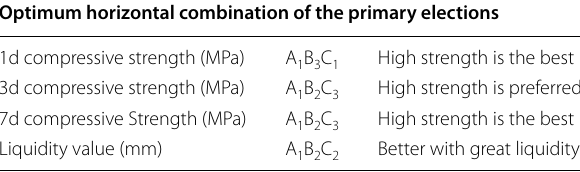
Table 21 Primary-based optimal level